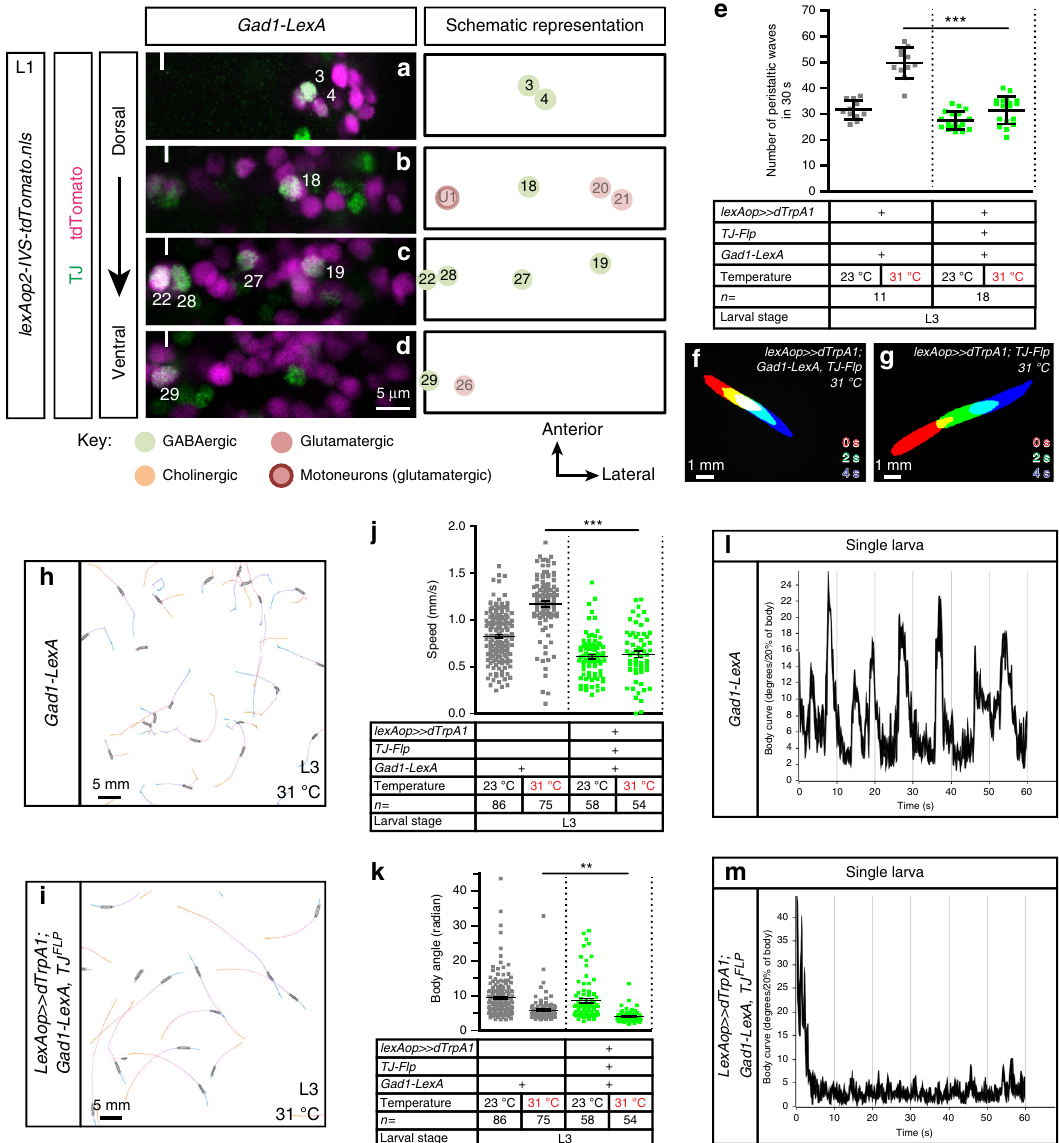
Fig. 6 Activation of TJ + GABAergic INs reduces crawling speed of larvae navigating in smooth runs. a – d Representative views of one hemisegment of a fi rst instar larval VNC stained for TJ (green) and GABAergic cells (magenta, using Gad1-LexA- driving lexAop-nlsTomato ). Cells are shown from dorsal ( a ) to ventral ( d ) positions. The full line indicates the midline and anterior of the VNC is up. TJ + cholinergic GABAergic neurons are represented in bright color while other non-GABAergic neurons are shown with paler colors. The identity of those neurons is inferred from their position compared to TJ + GABAergic neurons. e Number of peristaltic waves per 30 s at (23 °C) and (31 °C) of larvae expressing TrpA1 in TJ + GABAergic neurons (green dot plot) versus their respective controls that do not express TrpA1 (gray dot plot). Each single point represents a single third instar larva. Error bars indicate the mean ± SD and n the number of larvae tested. Statistical analysis: one-way ANOVA. *** p ≤ 0.001. f , g Superimposition of three consecutive time frames (0, 2, and 4 s) showing the postures of control third instar larvae ( f ) and upon activation of the TJ + GABAergic population ( g ). h , i Traces of control larvae ( h ) and upon activation of the TJ + GABAergic population ( i ) recorded using the MWT automated behavioral device. j Speed of larvae expressing TrpA1 in TJ + GABAergic neurons (green dot plot) versus their respective controls that do not express TrpA1 (gray dot plot). k Body angle (in radian) of larvae expressing TrpA1 in TJ + GABAergic neurons (green dot plot) versus their respective controls that do not express TrpA1 (gray dot plot). j , k Statistical analysis: Z -test. *** p ≤ 0.001. ** p ≤ 0.01. l , m Body curve measurement for a single control larva ( l ) and a single larva upon activation of the TJ +